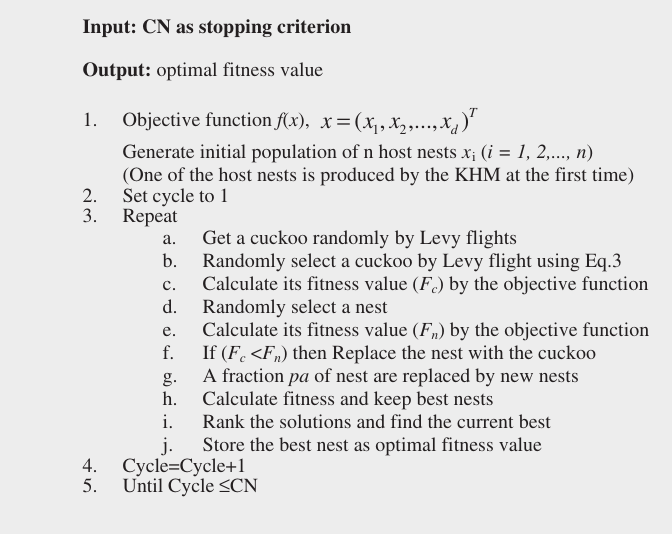
Figure 1: Pseudo-code of Levy Flight Cuckoo Search